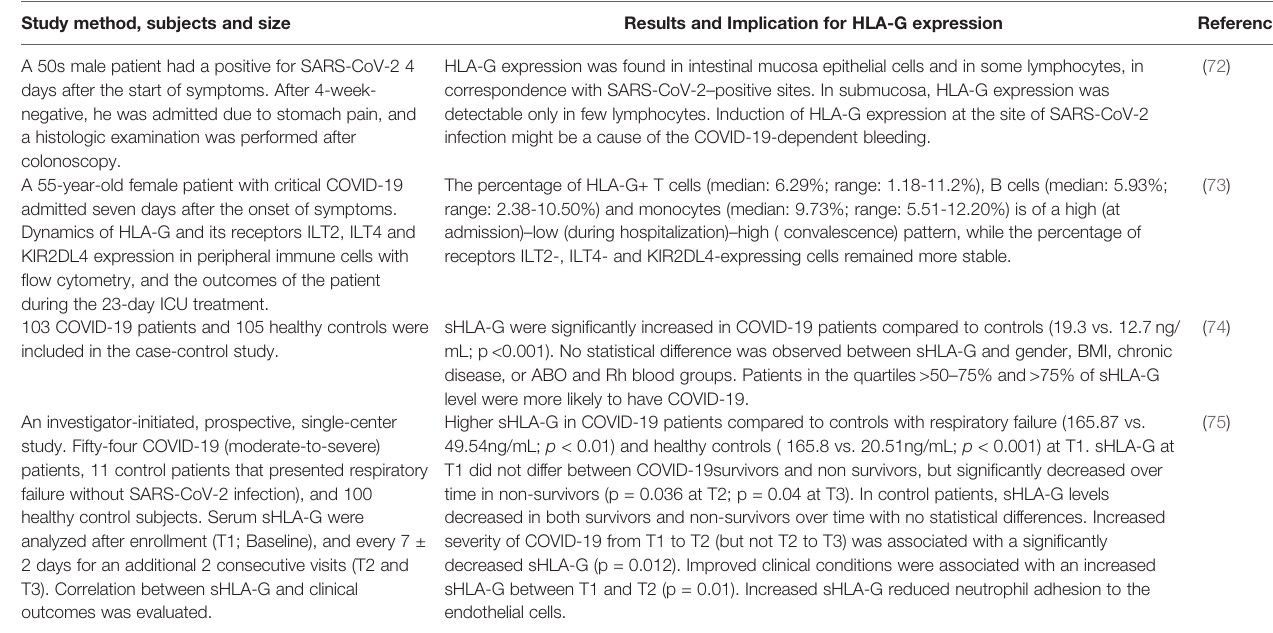
TABLE 1 | Current available studies on HLA-G expression in patients with COVID-19. Study method, subjects and